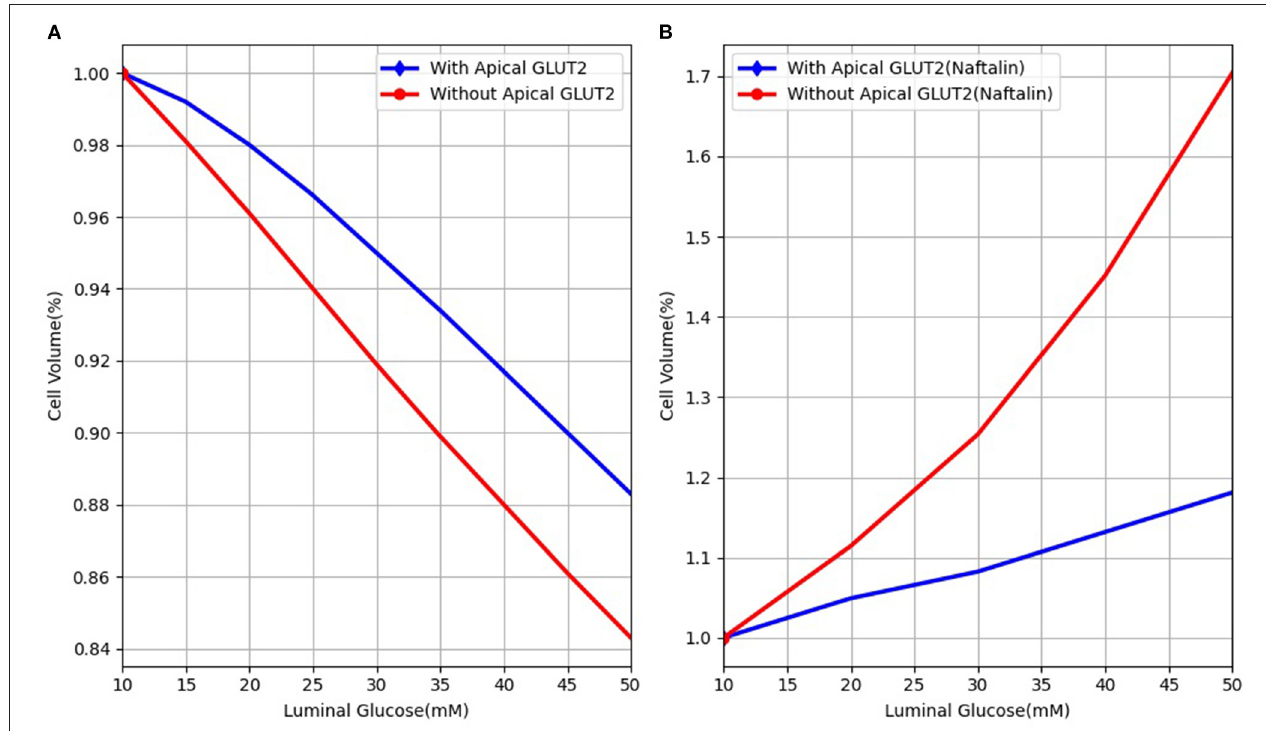
FIGURE 9 | Cell volume behaviour in response to different luminal glucose levels in (A) our model and (B) Naftalin (2014) model. Values are normalised to baseline